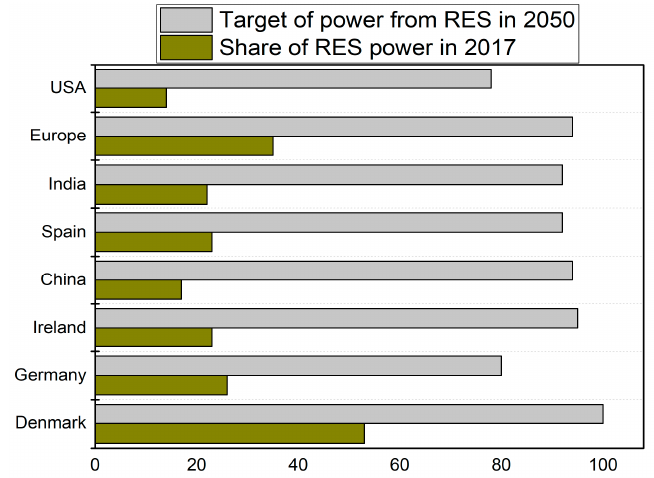
Figure 1. Renewable energy share and targets by countries in 2017 and 2050